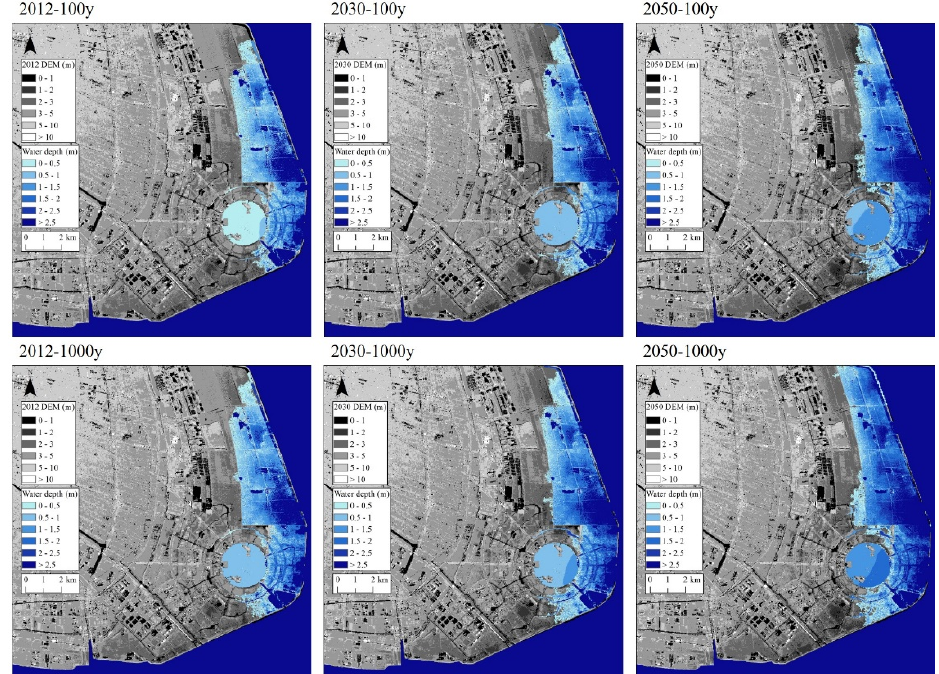
Figure 7. Inundation map for Lingang New City of Shanghai in 2015, 2030, and 2050 under two simulated levee-breach inundation scenarios (100 year and 1000 year) modelled with TanDEM-X DEM and ground subsidence (refer to